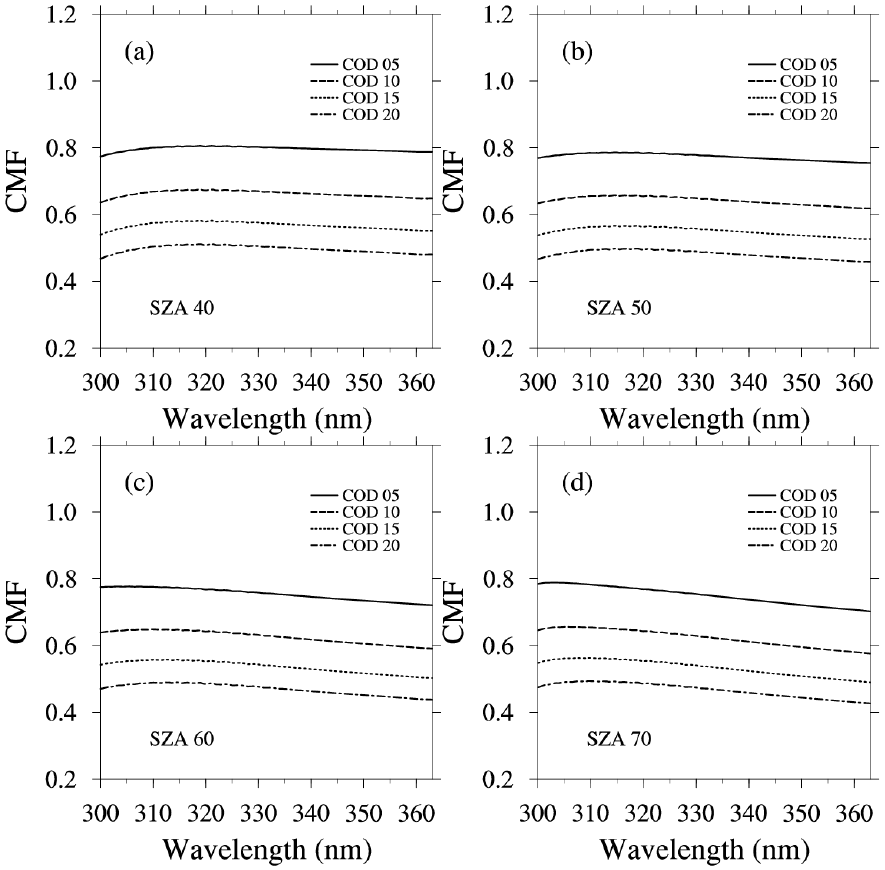
Figure 5. Simulated spectral CMF for overcast sky with cloud optical depth (COD) of 5, 10, 15, and 20 at SZA of: ( a ) 40°; ( b ) 50°; ( c ) 60°; and ( d ) 70°. Table 3. Spectrally averaged theoretical CMF and its geometric difference by changing 10° of SZA.